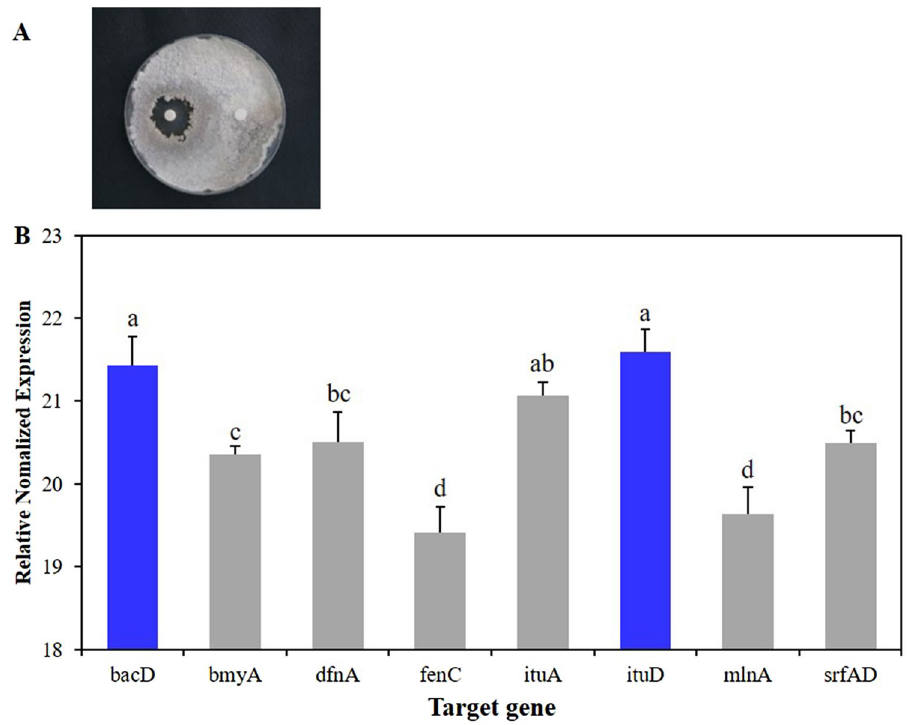
Figure 7. Gene expression analysis of secondary metabolites from the B. velezensis AK-0 genome using qPCR. ( A ) Secondary metabolites produced by AK-0 when interacted with a pathogen by producing an inhibition zone ( B ) Among the eight genes, the ituD , and bacD genes were expressed at a greater level than other genes from the B. velezensis AK-0